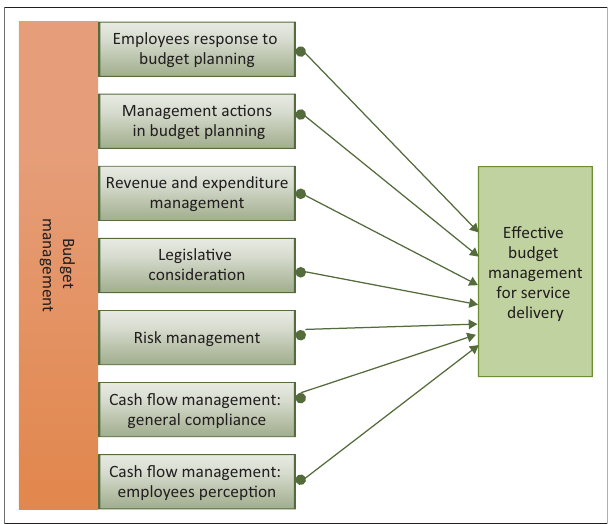
FIGURE 4: Revised